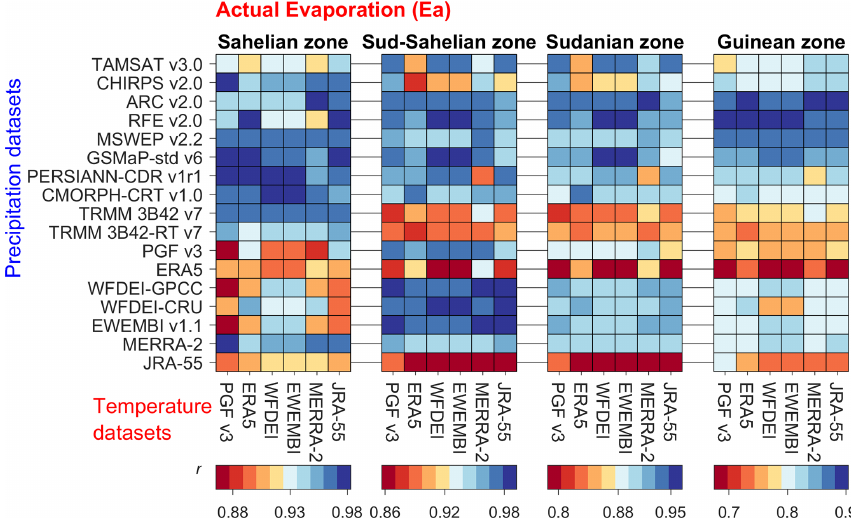
Figure 8. Pearson correlation coefficient ( r ) of modelled actual evaporation ( E a ) compared to GLEAM data over the simulation period (2003–2012) considering 102 combinations of rainfall ( y axis) and temperature datasets (subplots on the x axis) used as forcing for the hydrological